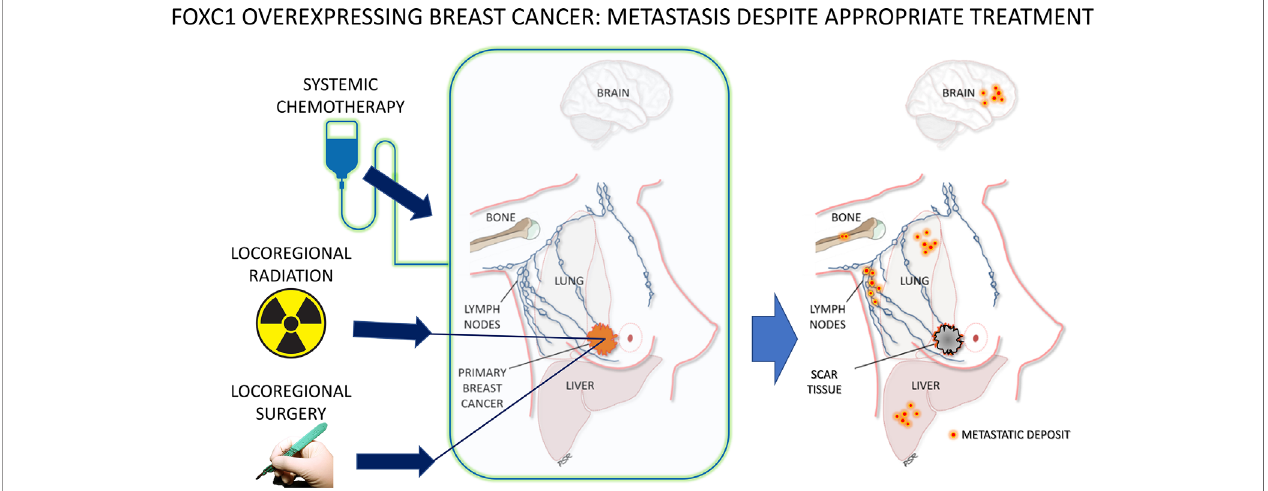
FIGURE 1 | Clinical hallmarks of FOXC1-overexpressing breast cancer – metastatic recurrence despite adequate surgical resection, lymph node assessment and removal, radiation therapy and chemotherapy. For a biomarker to be associated with such aggressive behavior, resistant to common therapeutic treatment approaches, argues strongly in favor of this being a manifestation of the cancer stem cell